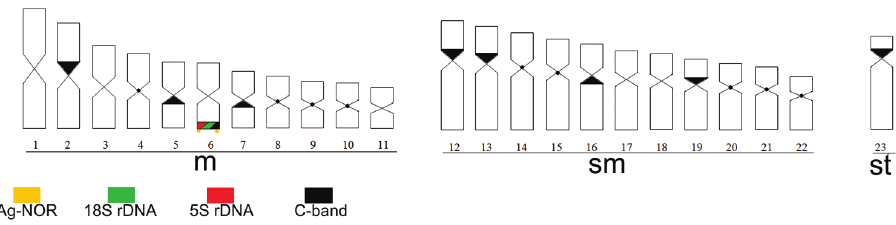
Figure 3. Ideogram of Corydoras carlae , showing the heterochromatin, Ag-NORs, 18S and 5S rDNA distribution